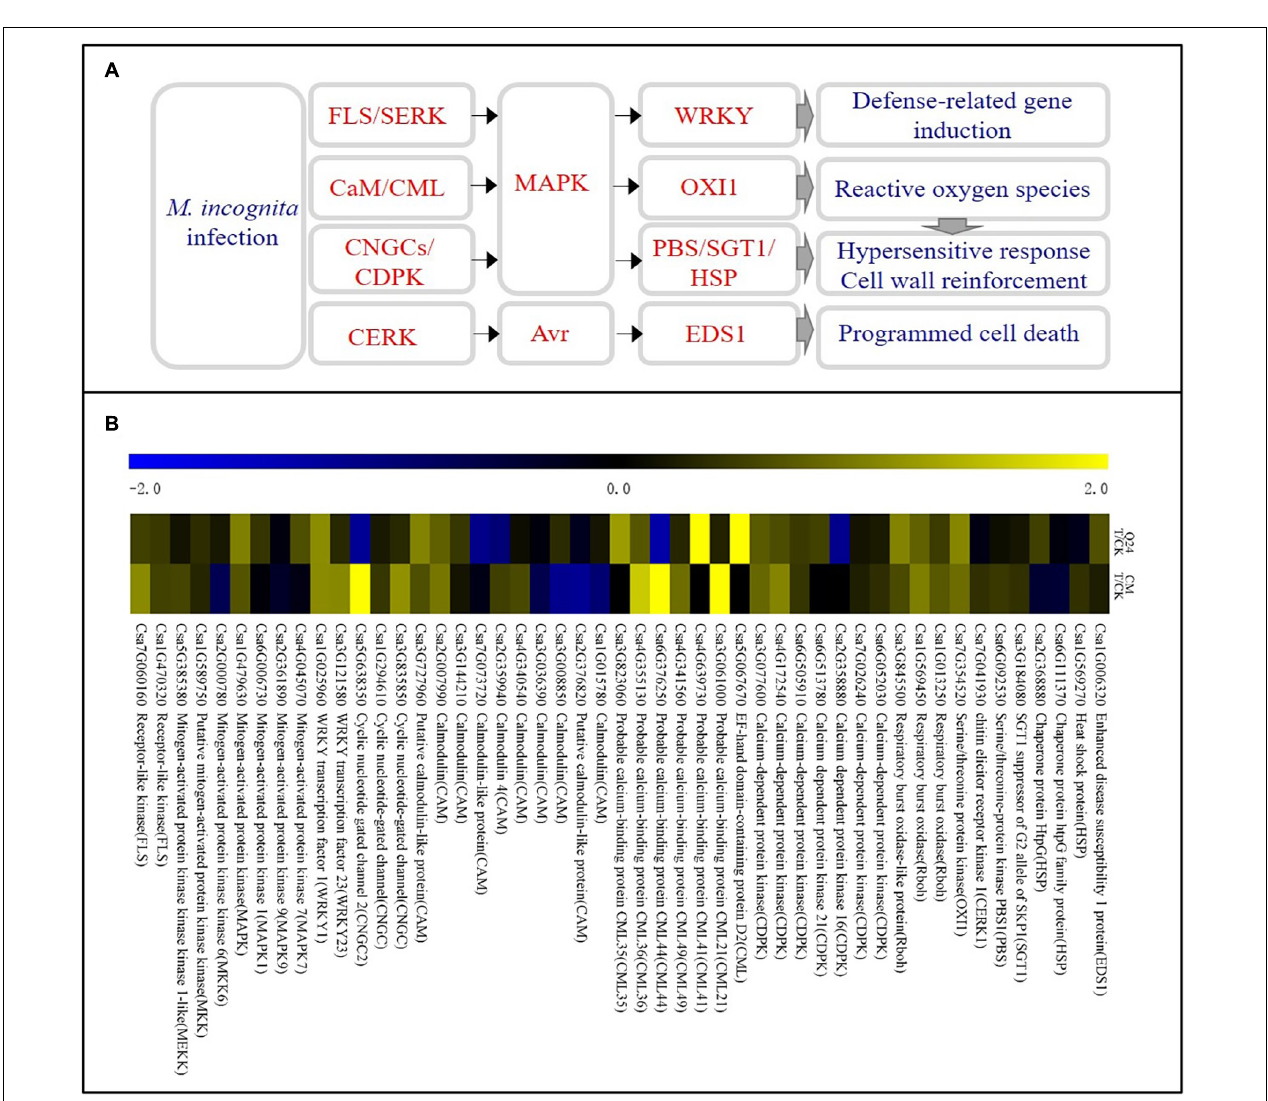
FIGURE 4 | Ca 2 + signaling pathway and heat map of differentially expressed genes in Q24 and CM responding to infection. (A) All differentially expressed genes mapped to Ca 2 + signaling of Q24 and CM responding to infection; (B) the heat map showed the value of the log2FoldChange of genes compared with that of the control in plant defense in Q24 and CM. Yellow indicated up expression and blue indicated down